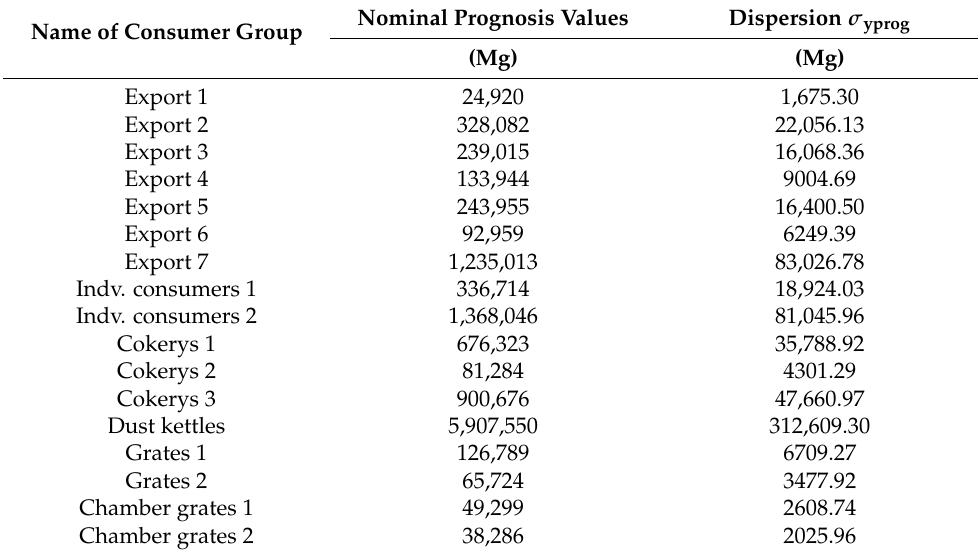
Table 6. A summary of the nominal values of the forecast of the demand from the consumer groups and of the dispersion σ yprog.